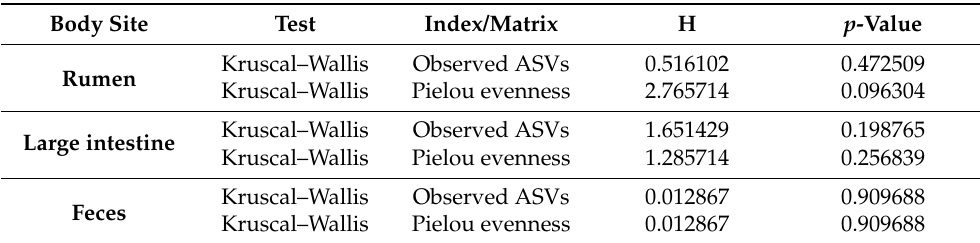
Table 3. Alpha diversity analysis of GIT microbiota characterized in traditional vs. alternatively fed